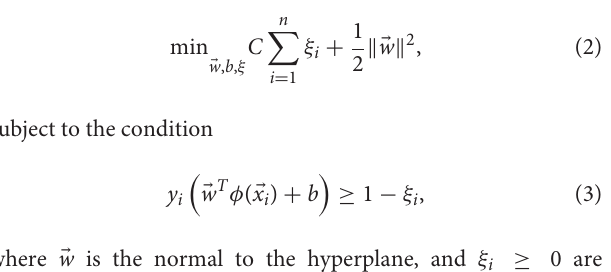
a activation function while the subsequent pooling also consisted of a maximum poling with non-overlapping regions of size 2 × 2 dropout technique was also applied with same retention rate yielding to 68100 parameters corresponding 68000 convolutional kernel weights, 100 convolutional kernel biases. The output map of this layer resulted in 100 feature maps of size 2 × 3. The feed forward ANN consisted of 100 input neurons and 2 neurons in the output layer. The activation function in the hidden layer is the sigmoid while in the output layer is the